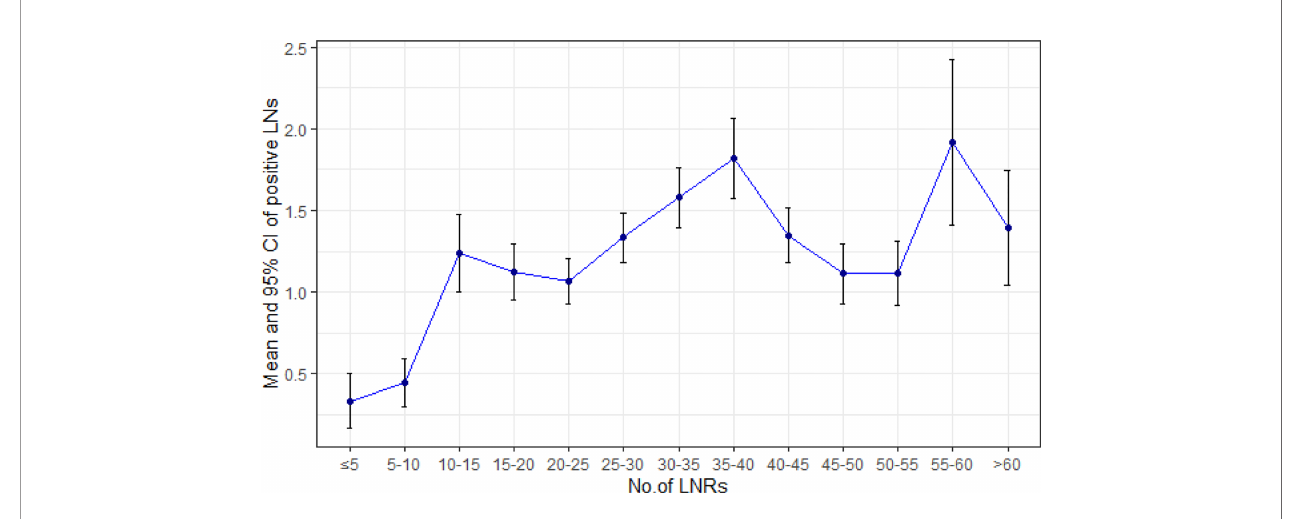
FIGURE 3 | Increasing pattern of mean numbers of positive LNs according to the number of